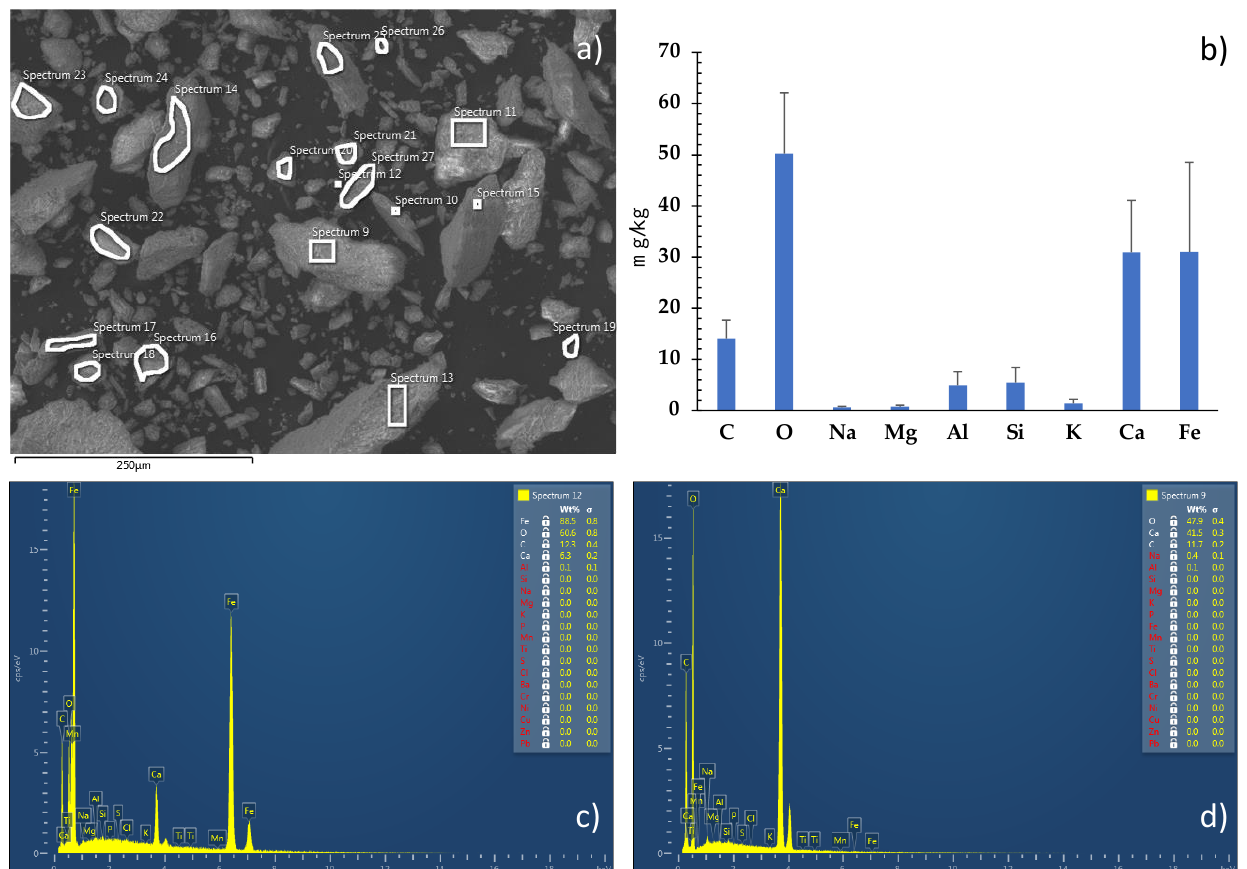
Figure 4. ( a ) FESEM micrograph of the pulverized carbonate matrix, with highlighted the areas selected for chemical analyses. ( b ) Weight percentage diagram of the elements identified using chemical microanalyses. ( c , d ) Energy Dispersion Spectra showing the relative abundance of the elements composing the matrix as a function of the peak’s intensity.